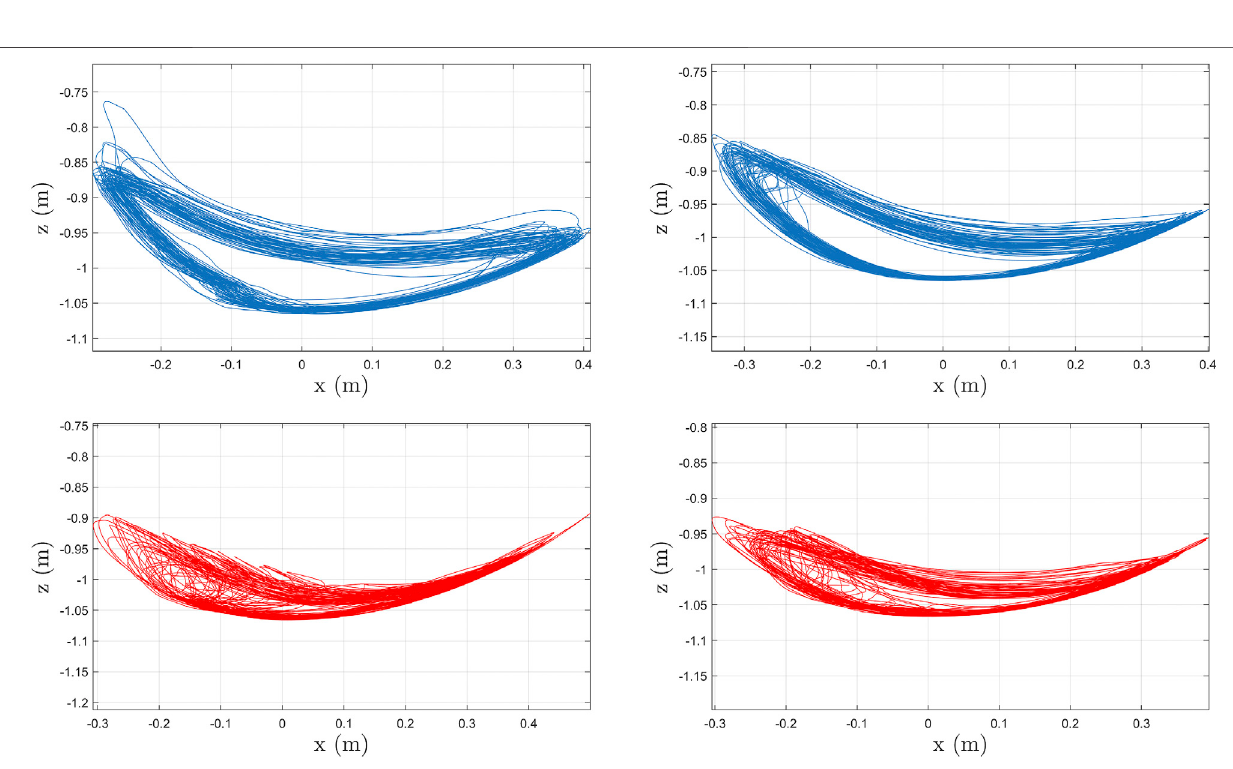
FIGURE11| Foot trajectories inthe sagittal plane (i.e.,the foot path inthe x-zplane) at high (top) and slow (bottom) speeds forSubject2(S2). Theplots inthe left column correspond to the left leg and plots in the right column correspond to the right leg. The trajectories are computed using collected joint angles, where the origin corresponds to the trunk